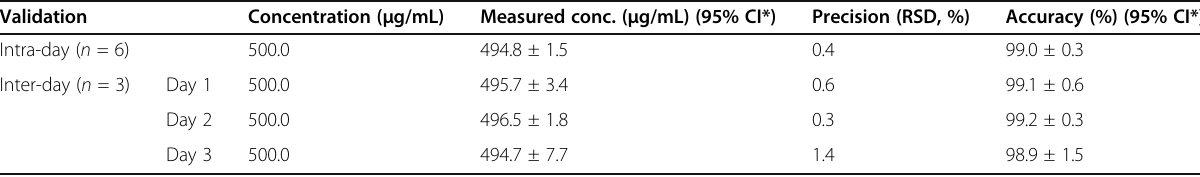
Table 2 Intermediate precision by method validation